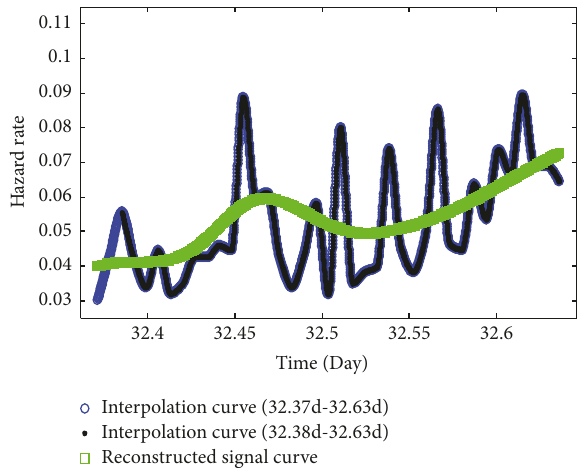
t e r a d r z a H a